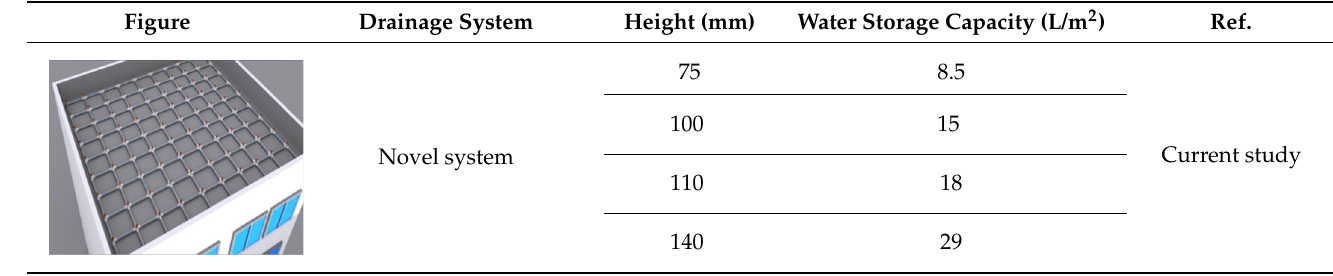
Table 3. Water storage capacity of the novel system and conventional drainage layer systems. Figure Drainage System Height (mm) Water Storage Capacity (L/m 2 ) Ref.